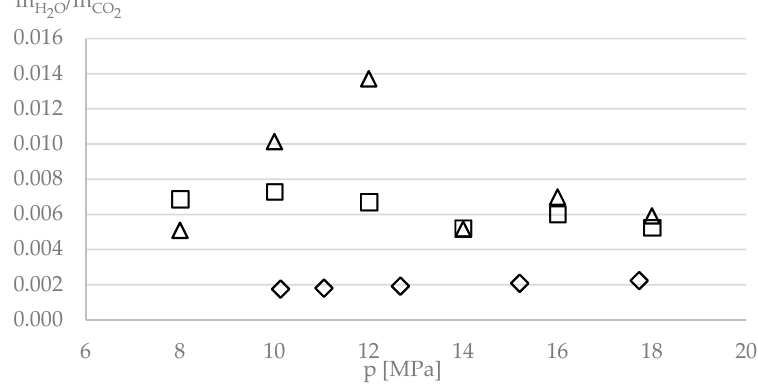
Figure 3. The relative amount of water in the gas phase for the quaternary □ , (CO 2 + 1,4-BDO + [hmim][B(CN) 4 ] + H 2 O) or ∆ , (CO 2 + 1,2-PDO + [hmim][B(CN) 4 ] + H 2 O) [this work], and the binary ♦